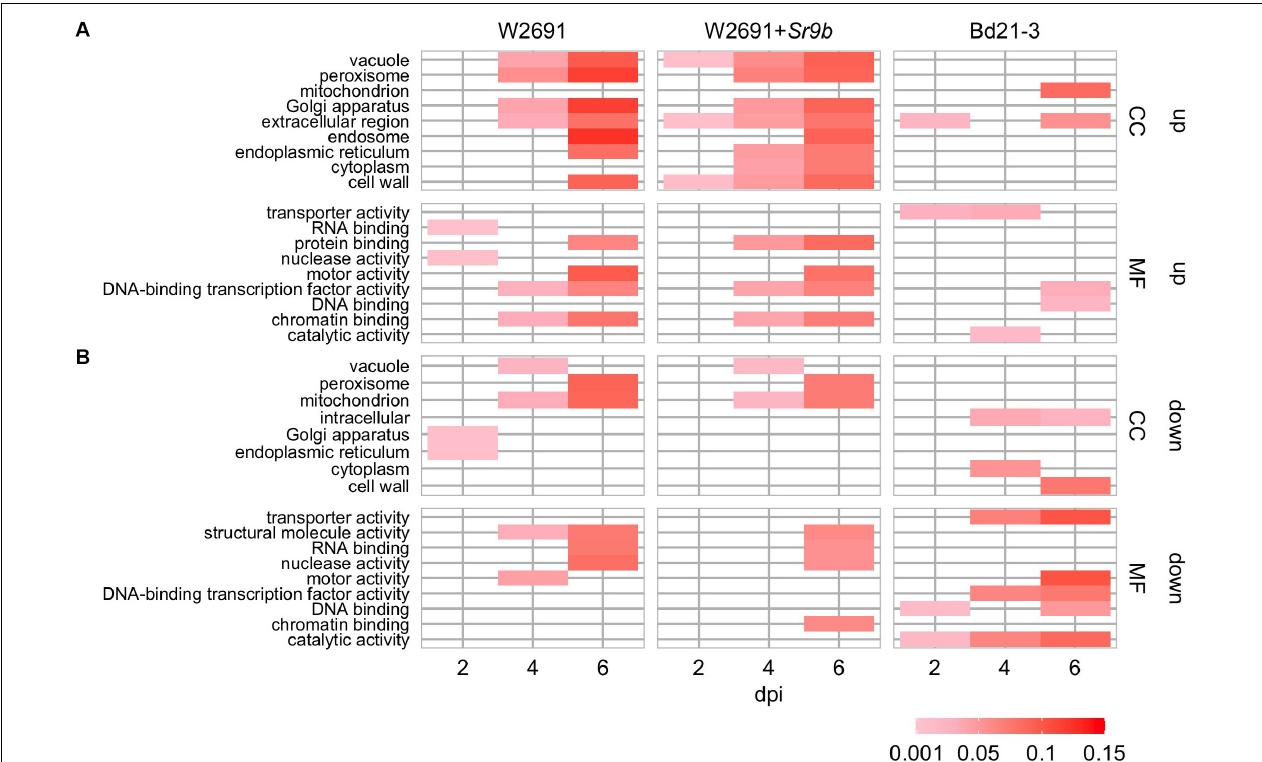
FIGURE 2 | GOslim enrichment analysis of differentially expressed (DE) genes in mock vs inoculated T. aestivum (W2691 and W2691+ Sr9b ) and B. distachyon (Bd21-3) genotypes across three time points (bottom x -axis) upon infection with P. graminis f. sp. tritici . (A) Enrichment of plant GOslim terms of up-regulated (up) DE genes and (B) down-regulated (down) DE genes. The y-axis shows plant GO slim terms separated by category: cellular component (CC) and molecular function (MF). The scale represents the proportion of genes annotated with each GO term to all the genes tested.